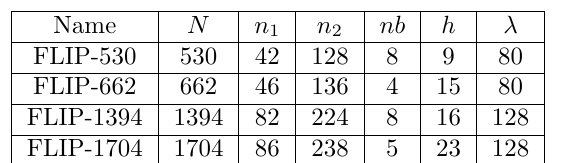
Table 1: FLIP filtering function instances, N is the total number of variables, n 1 is the number of variables over the linear part, n 2 is the number of variables over the quadratic part, nb is the number of triangular functions, h is the degree of the triangular functions and λ is the security